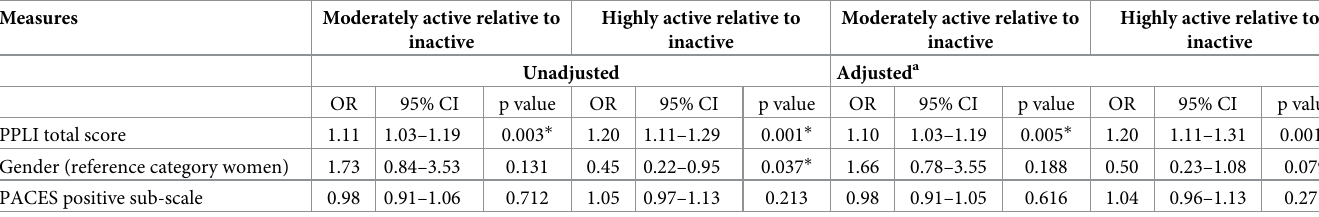
Table 4. Multinomial logistic regression analyses for moderately active or highly active participants relative to inactive.